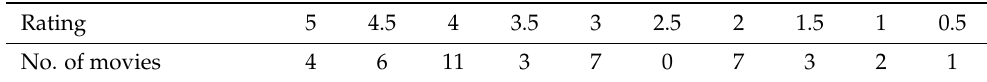
Table 9. Distribution of ratings by user u 6 .